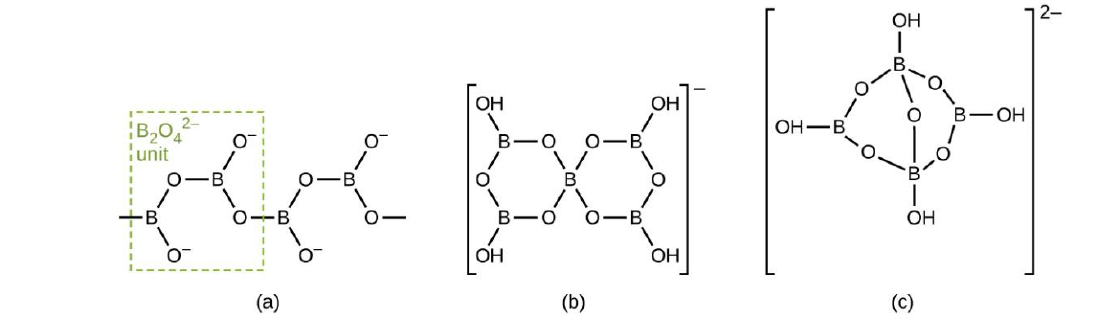
Fig. 1. The borate anions are (a) CaB 2 O 4 , (b) KB5O8 ⋅ 4H2O, and (c) Na2B4O7 ⋅ 10H2O. The anion in CaB2O4 is an “infinite” chain